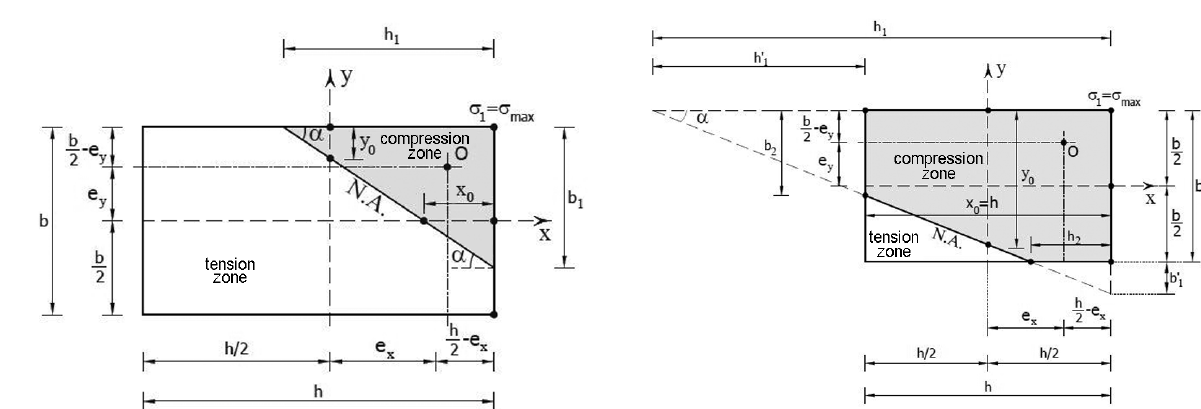
Fig. 5. Soil pressure distribution in rigid rectangular footing for the Case II